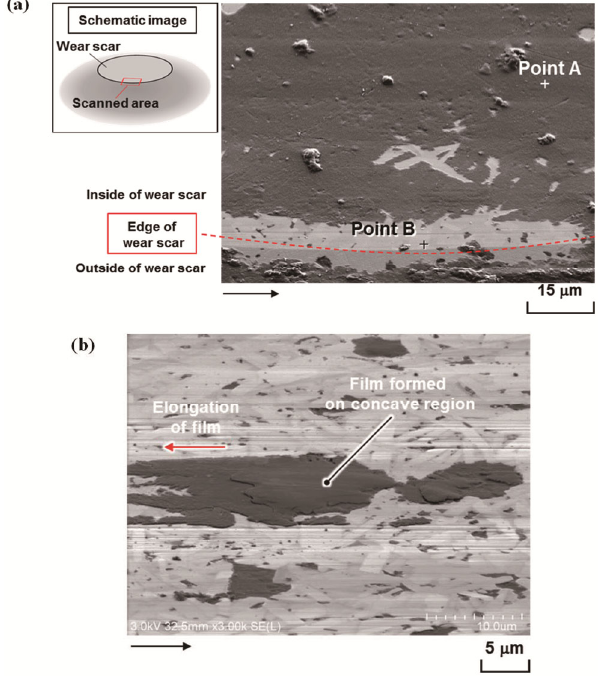
Fig. 9 Typical SEM images of contacting faces. (a) Wear scar in SiC ball after rubbing-in in ND–OH (1 wt%); schematic shows the scanned area of specimen, and film (point A) and substrate (point B) were analyzed by EDX. (b) Carbon films formed on wear track of SiC disk. Black arrows indicate sliding direction of counter material.